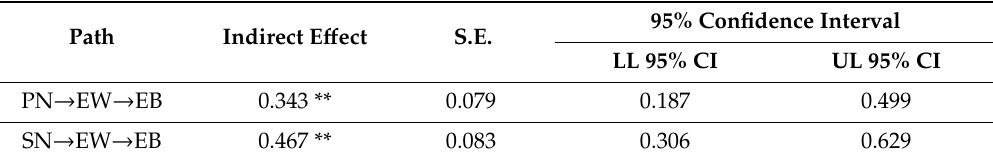
Table 5. Results of mediation e ff ect test.